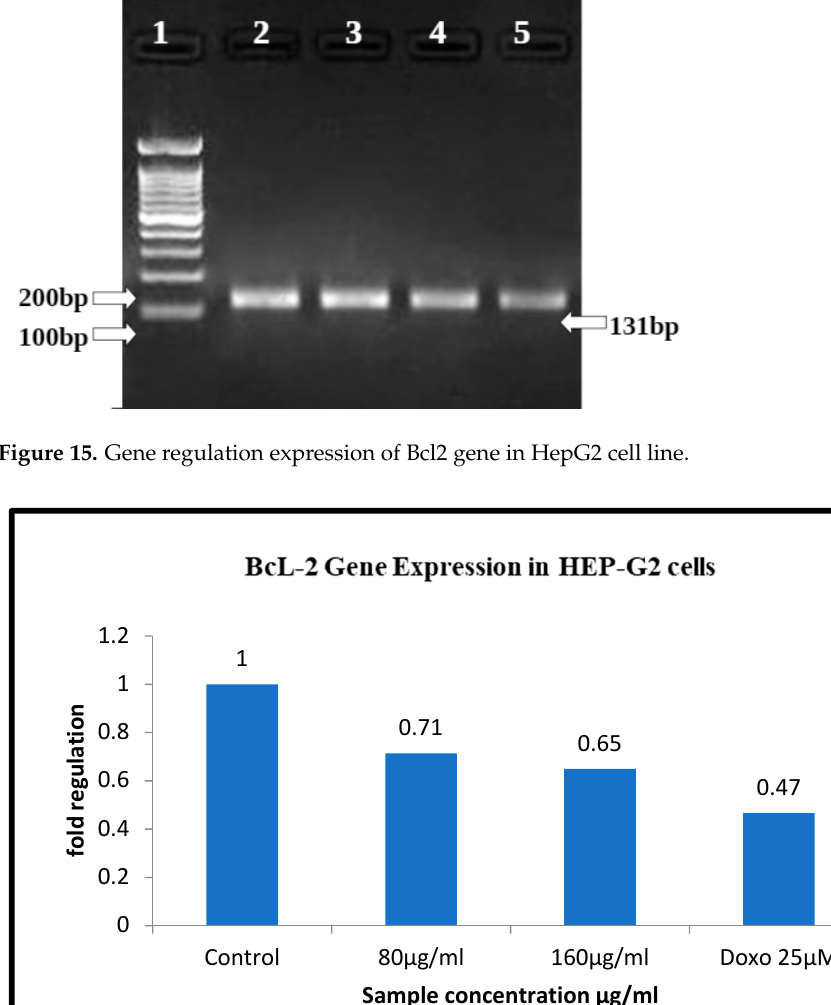
Figure 14. Graphical representation of BAX gene expression.